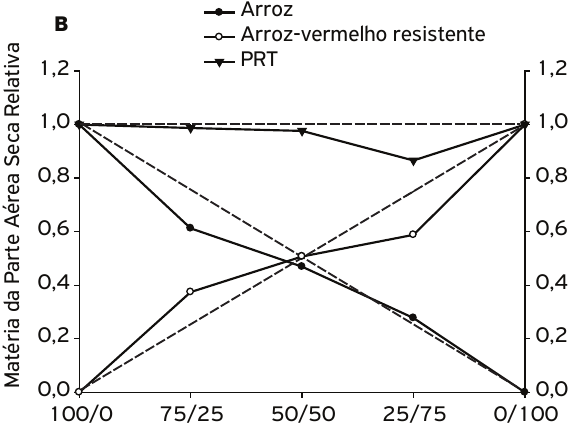
Figura 2. Produtividade relativa (PR) e total (PRT) para área foliar (A) e para matéria da parte aérea seca (B) de plantas de arroz e arroz-vermelho resistente, FAEM/UFPel, Capão do